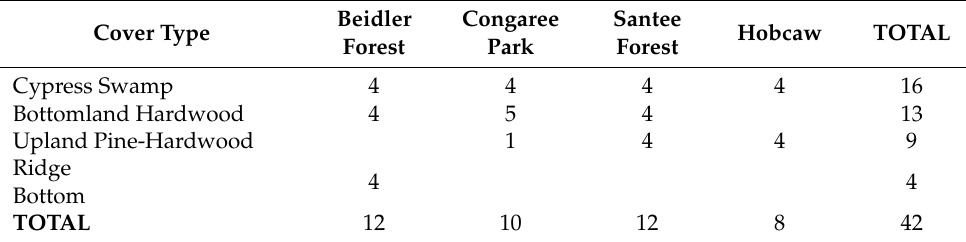
Table 2. Number of study plots present among four major sites and five forest cover